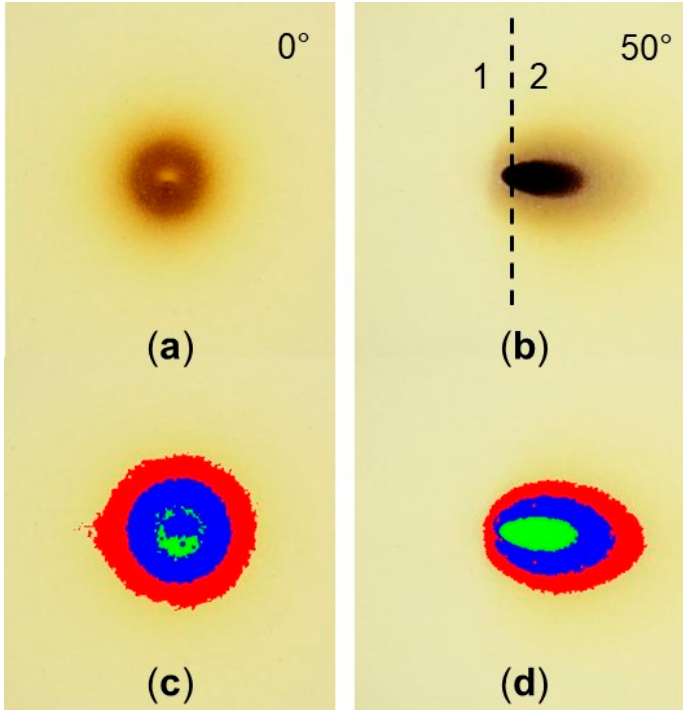
Figure 7. Effective treatment area of kINPen ® MED- β visualized by starch-potassium iodide plates at 8.5 mm distance after 45 s plasma treatment for ( a ) perpendicular treatment and ( b ) an incidence angle of 50° (side 1: inclination of the kINPen ® MED- β as shown in Figure 2c, side 2: area with plasma plume propagation) and ( c , d ) analyzed according to primary (green), secondary (blue) and peripheral (red) zones.